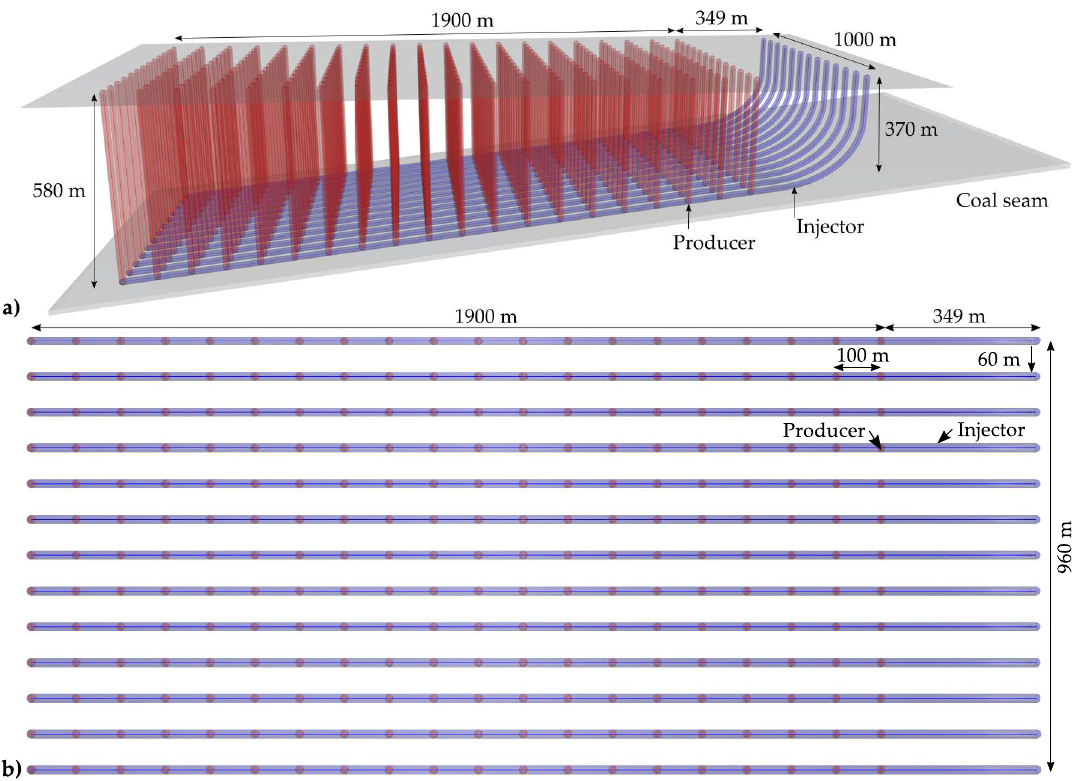
Figure 4. Computer-aided design model visualizing ( a ) 3D perspective and ( b ) plan views of the conceptual technical onshore well design for one underground coal gasification panel with 13 reactor channels and 260 production wells.